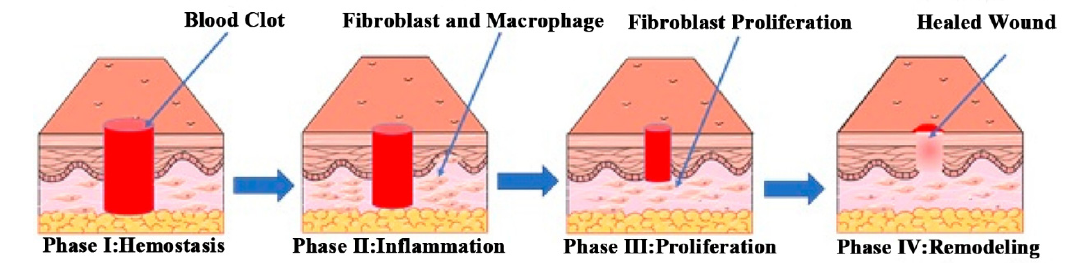
Figure 1. Schematic diagram of the normal wound healing process. Reproduced with permission from [17], ACS, 2019.